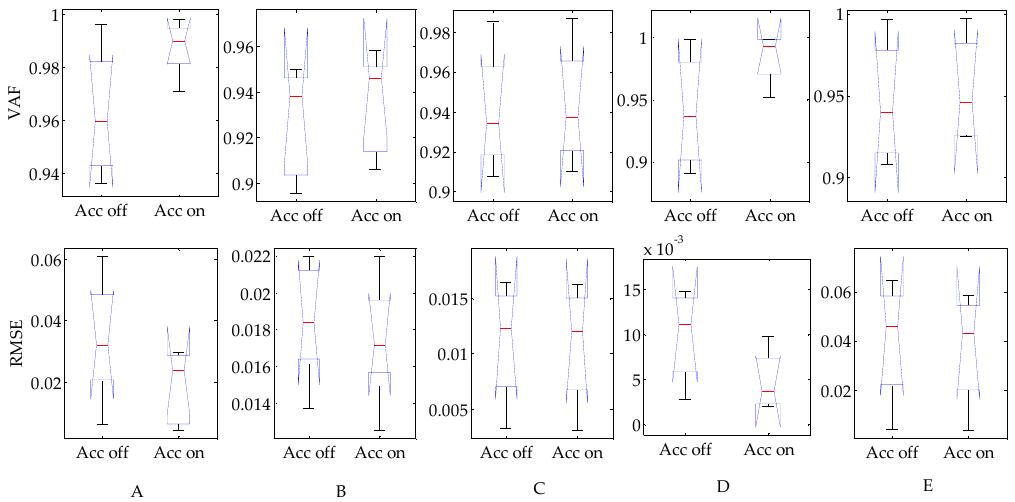
Figure 13. Boxplot of prediction results with and without acceleration. Column ( A ) to ( E ) represents the results of subject A to E, respectively. The p values of the first row are 0.041, 0.601, 0.922, 0.153 and 0.790, respectively. The p values of the second row are 0.164, 0.638, 0.958, 0.160 and 0.872, respectively.